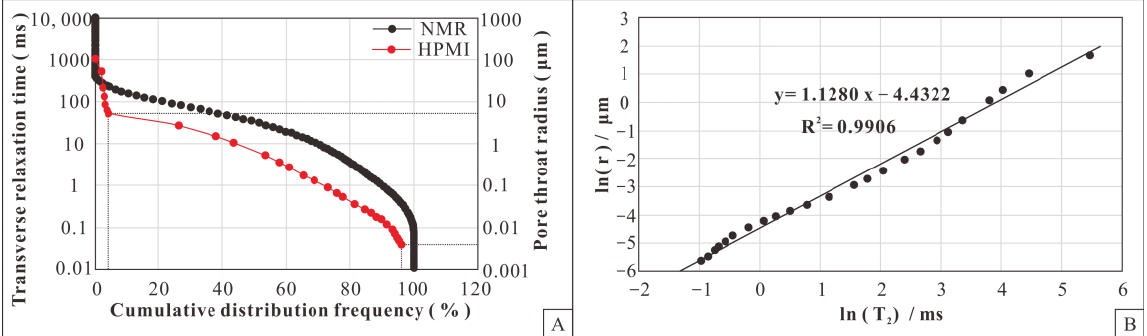
Figure 11. ( A ) Cumulative distribution curves of sample J9 NMR and HPMI; ( B ) least squares T 2 spectrum and pore-throat radius fitting based on NMR cumulative curve interpolation.